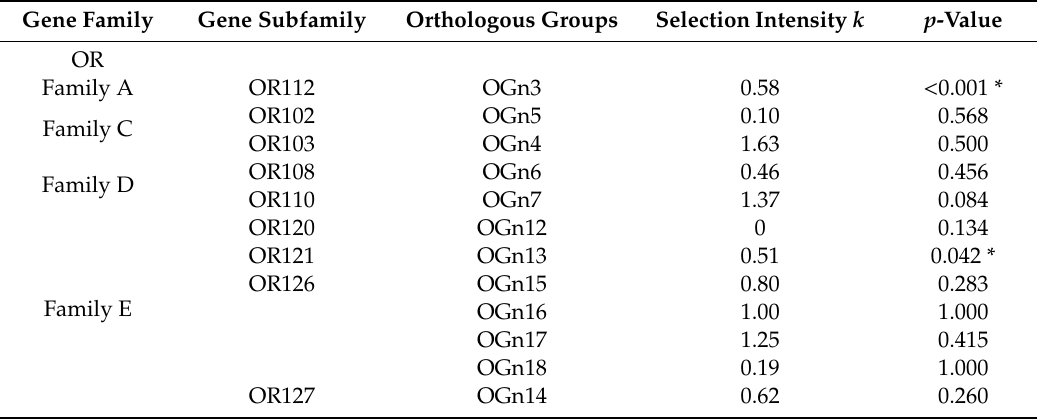
Table 1. Test for shift in selective pressures using RELAX. OR—olfactory receptor; TAAR—trace amine-associated